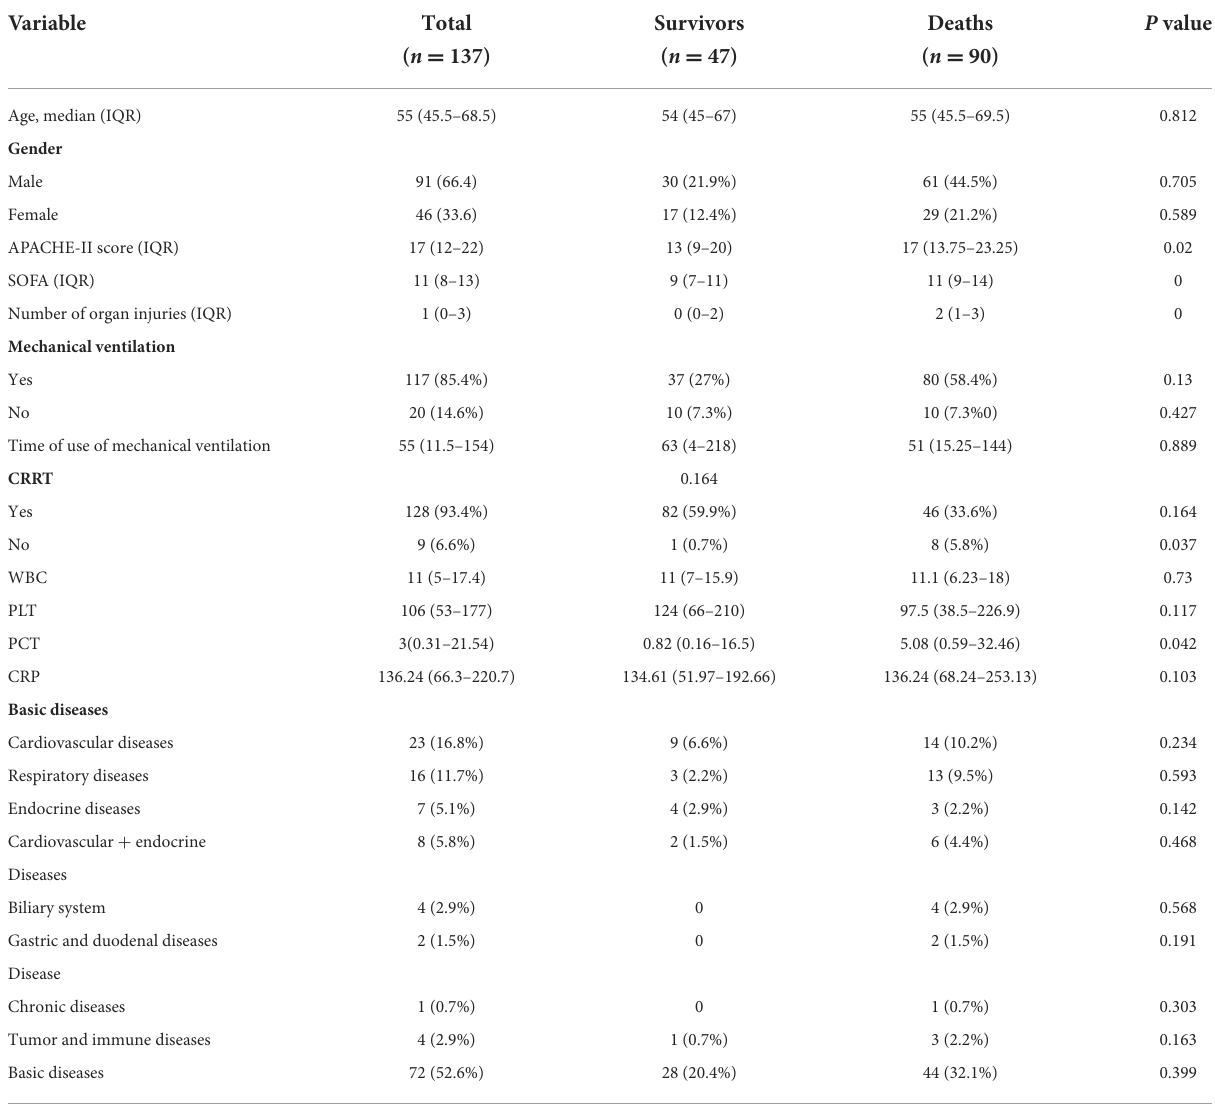
TABLE 2 Population characteristics by septic shock outcom.